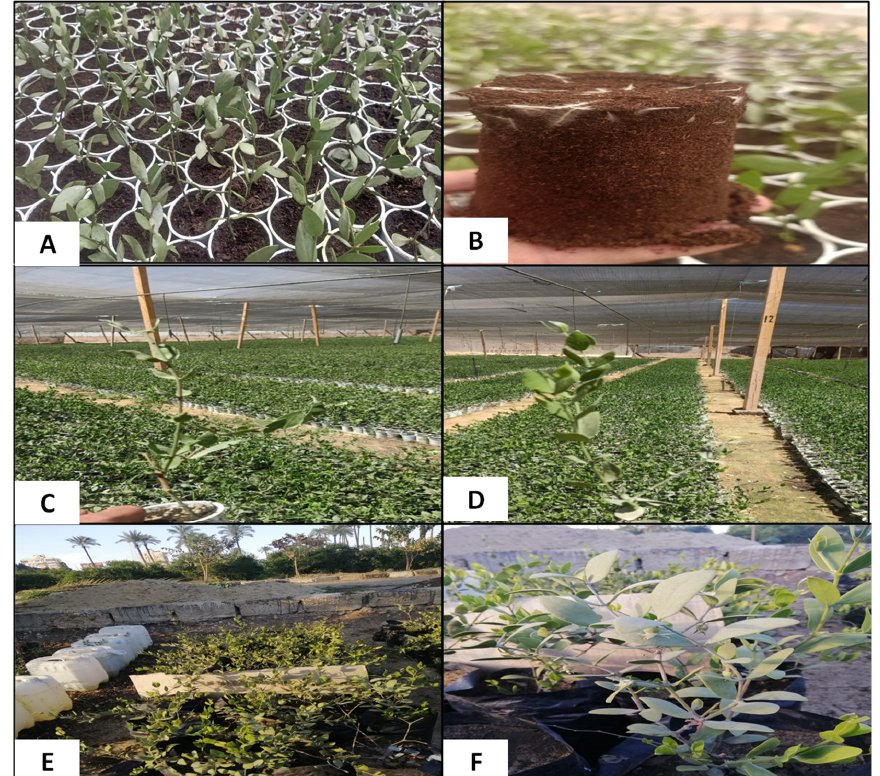
Figure 1. ( A ) The shape of the used tip cutting in propagation; ( B ) the tip cutting shape after rooting; ( C ) the jojoba plant propagation in a greenhouse located in Alexandria, Egypt ( 30°53 ′ 08.7 ″ N and 28°45 ′ 0.7.5 ″ E); ( D ) the shape of the plant at the beginning of the experiment; ( E , F ) the shape of the plant at the end of the experiment (after four months of the